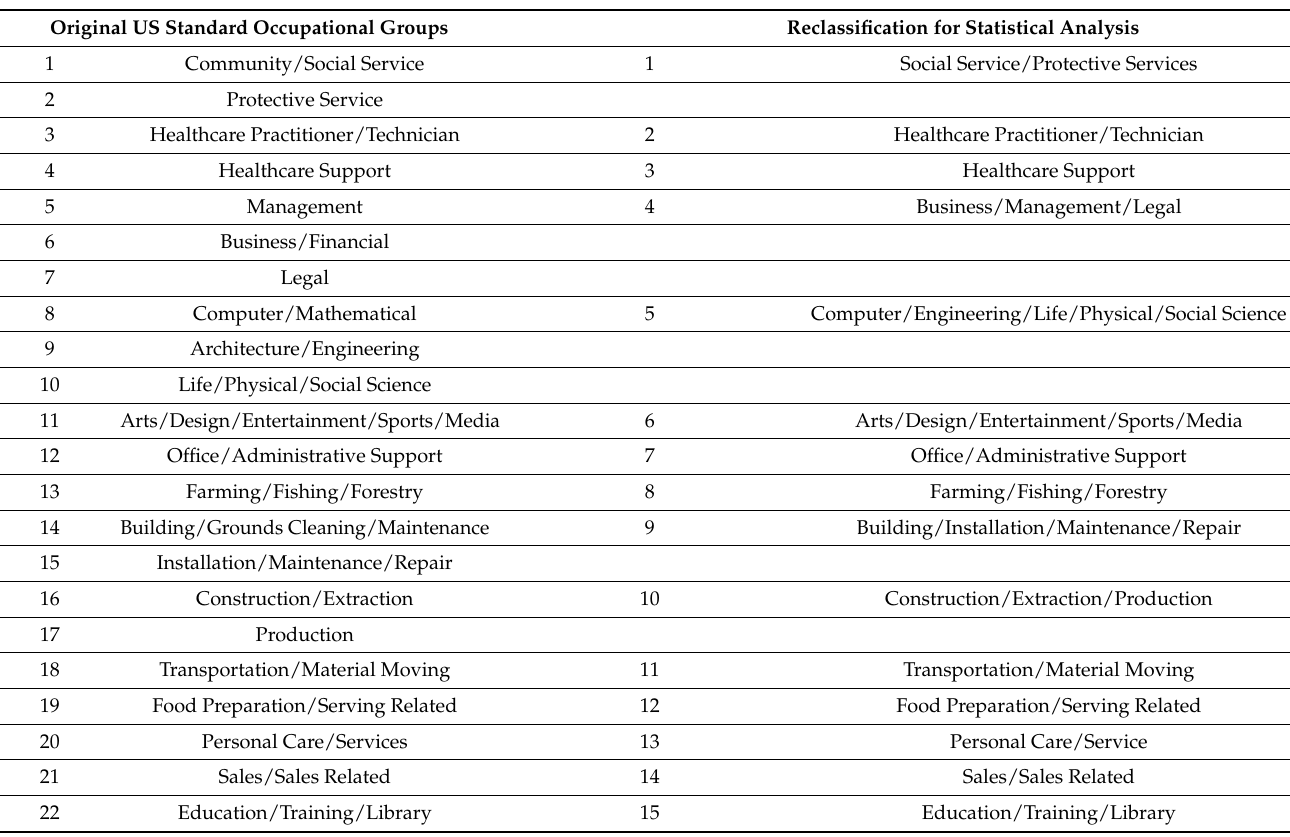
Table 1. The US Bureau of Labor Statistics classification of the standard occupational groups and our reclassification for the statistical